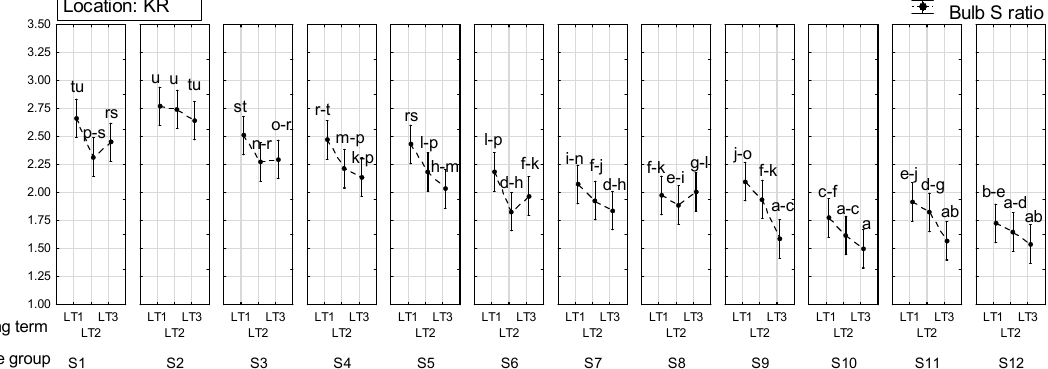
Figure 10. Effect of size group and lifting term on bulb S ratios for Krakow (KR) location. Mean values with different letter are significantly different according to Duncan’s multiple range test at p ≤ 0.05. For treatments description, see 2.1.–2.4, Materials and Methods sections.